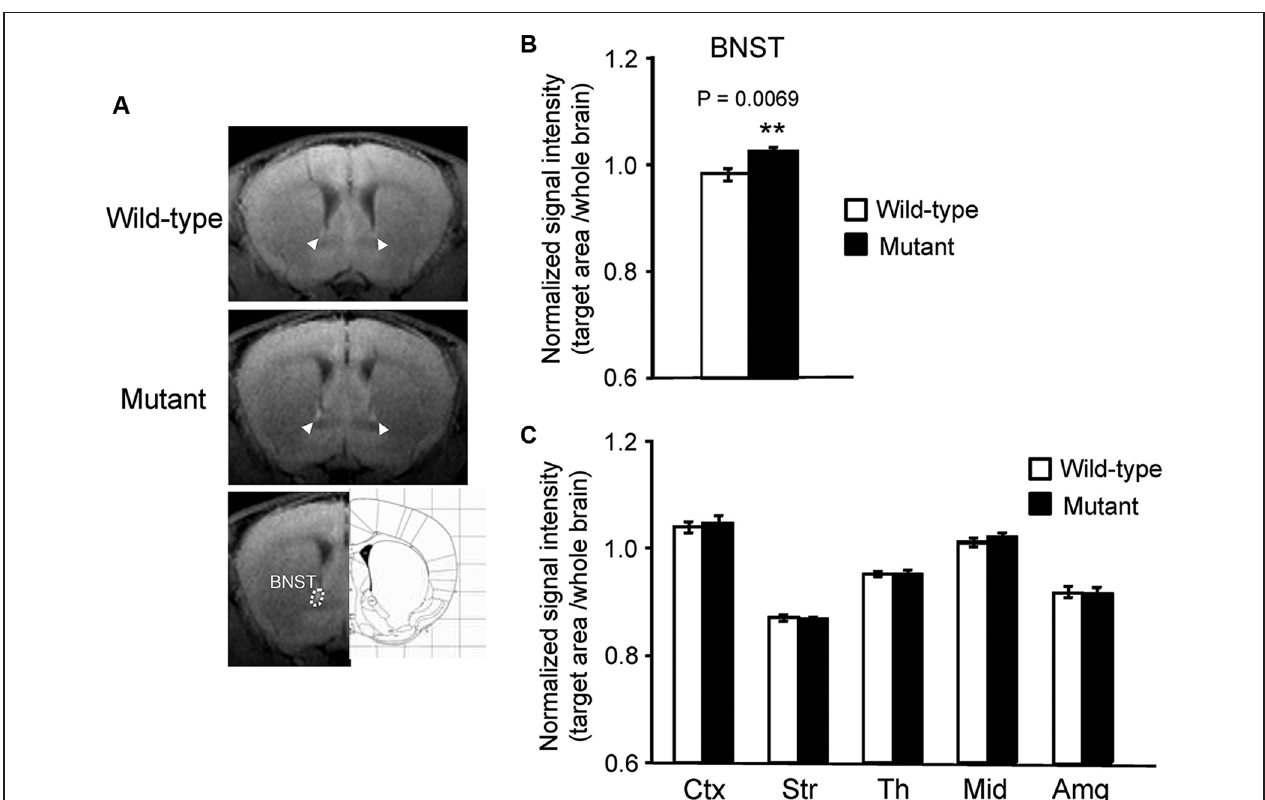
(B) Normalized signal intensity in the BNST is presented as the mean ± SEM for the indicated numbers of animals (C) Normalized signal intensities in other regions of the brain are presented as the mean ± SEM.The p values indicate the effect of genotype in one-way